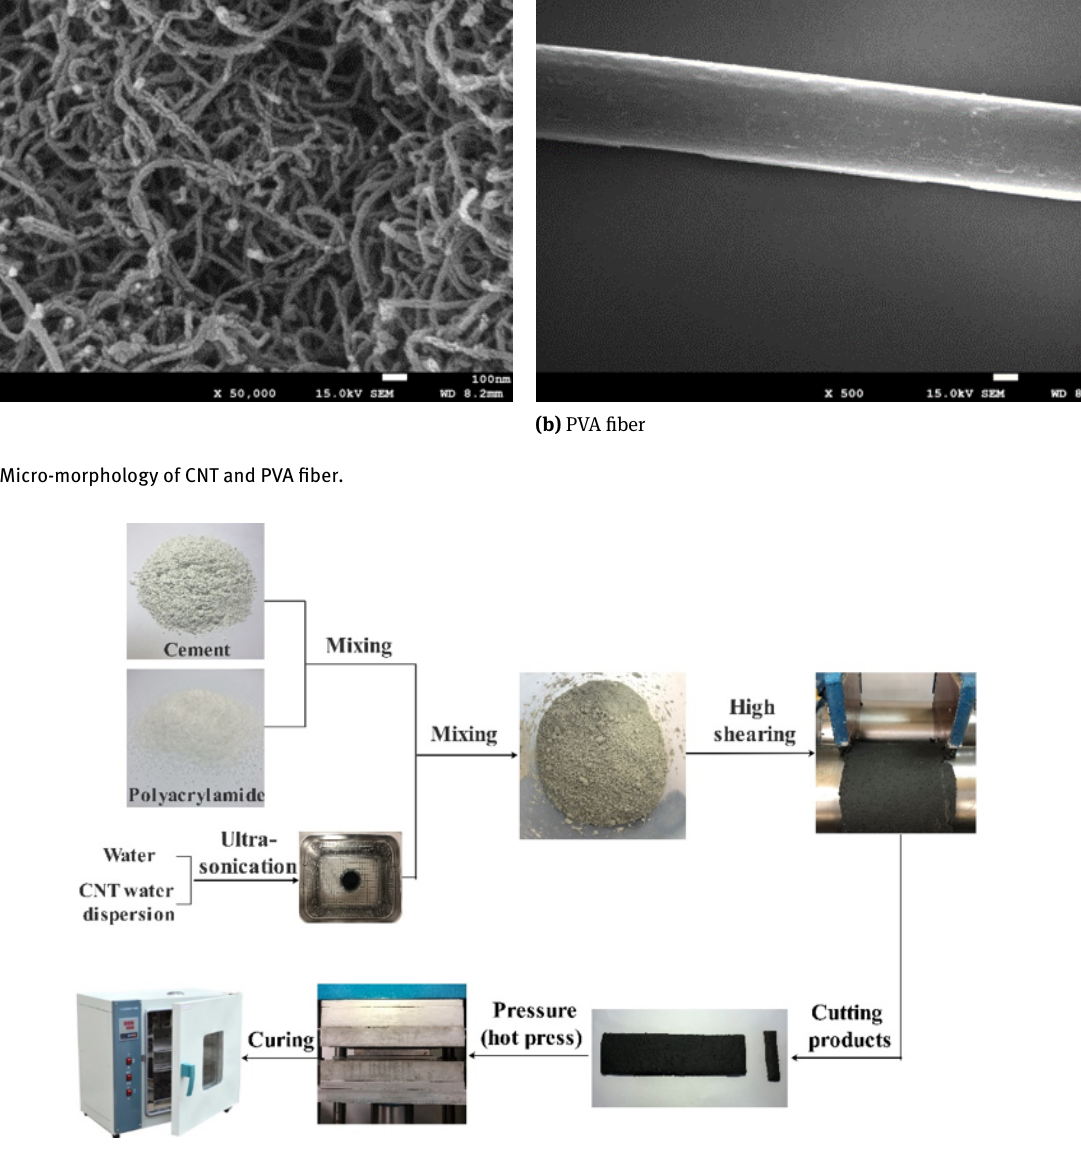
Figure 2: Basic steps to produce MDF cements with